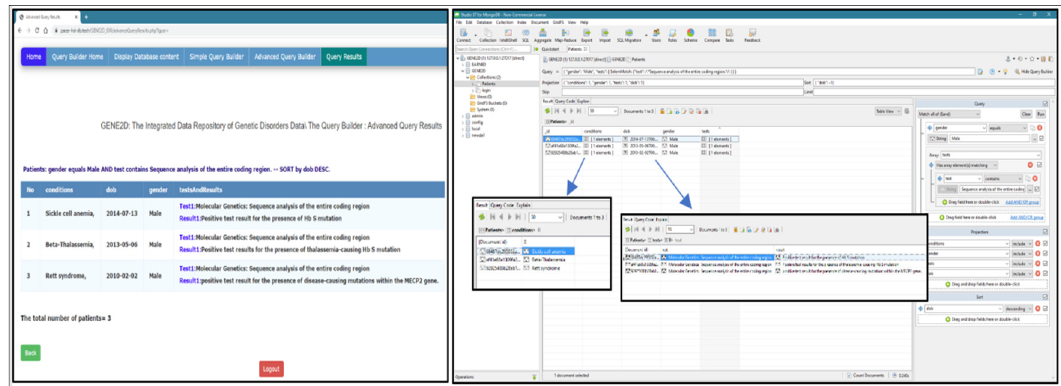
Figure 14. Testing advanced query, field type array of objects with a logical operator.